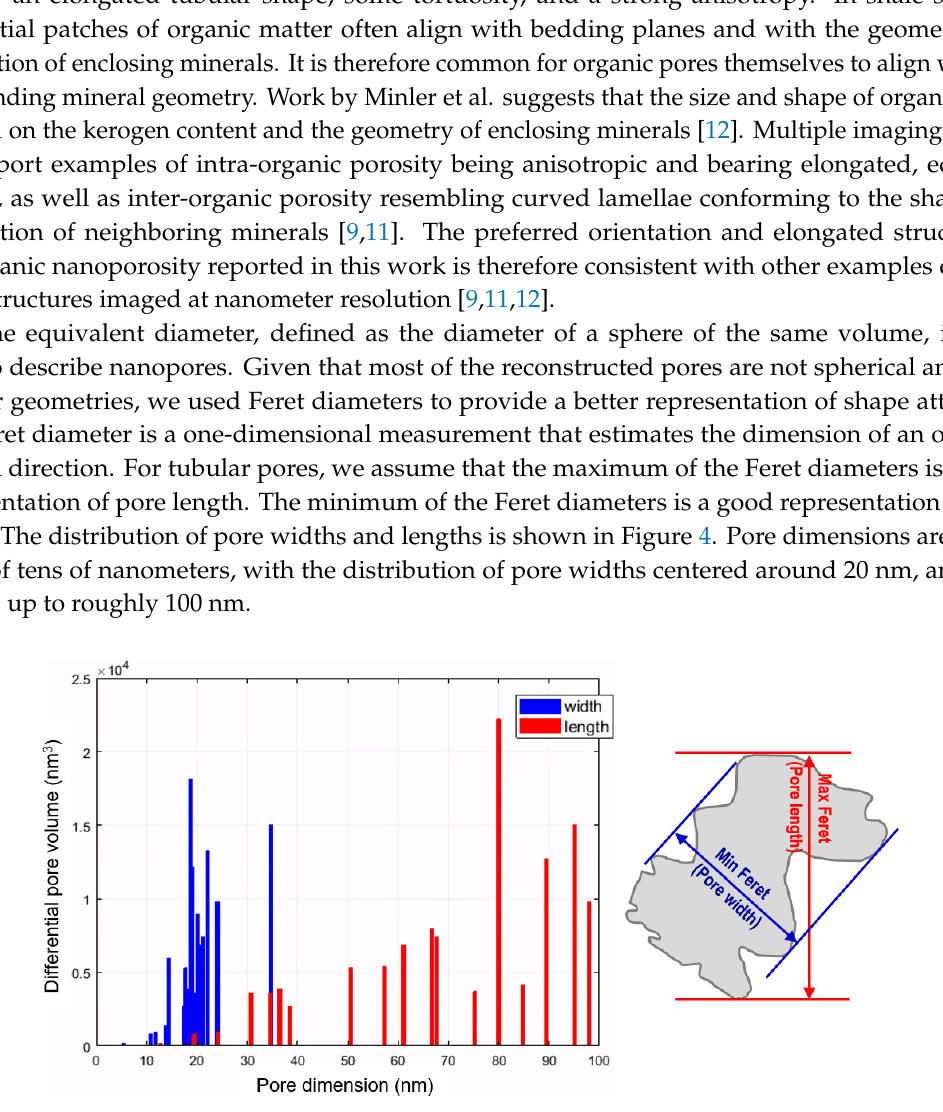
Figure 4. Pore size distribution (pore width and length are measured with Feret diameters).